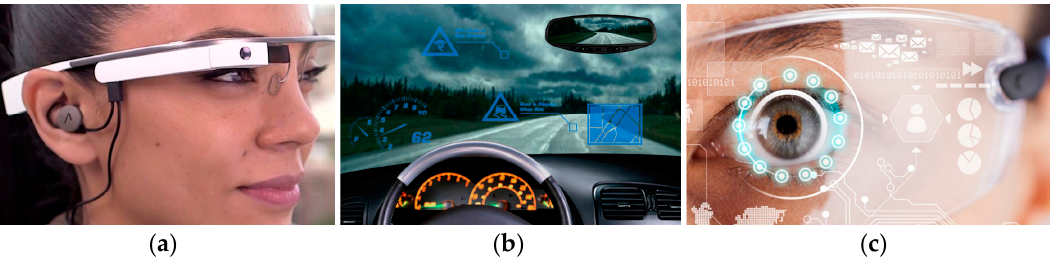
Figure 5. As Roland Barthes wrote [7,8], the device itself is so crucial for cognitive aspects of the sight, to generate a techno-human hybrid, such as: ( a ) Google glass ; ( b ) ‘Heads-up display’ (HUD) in a car; ( c ) Microsoft Hololens , controlled by eye’s